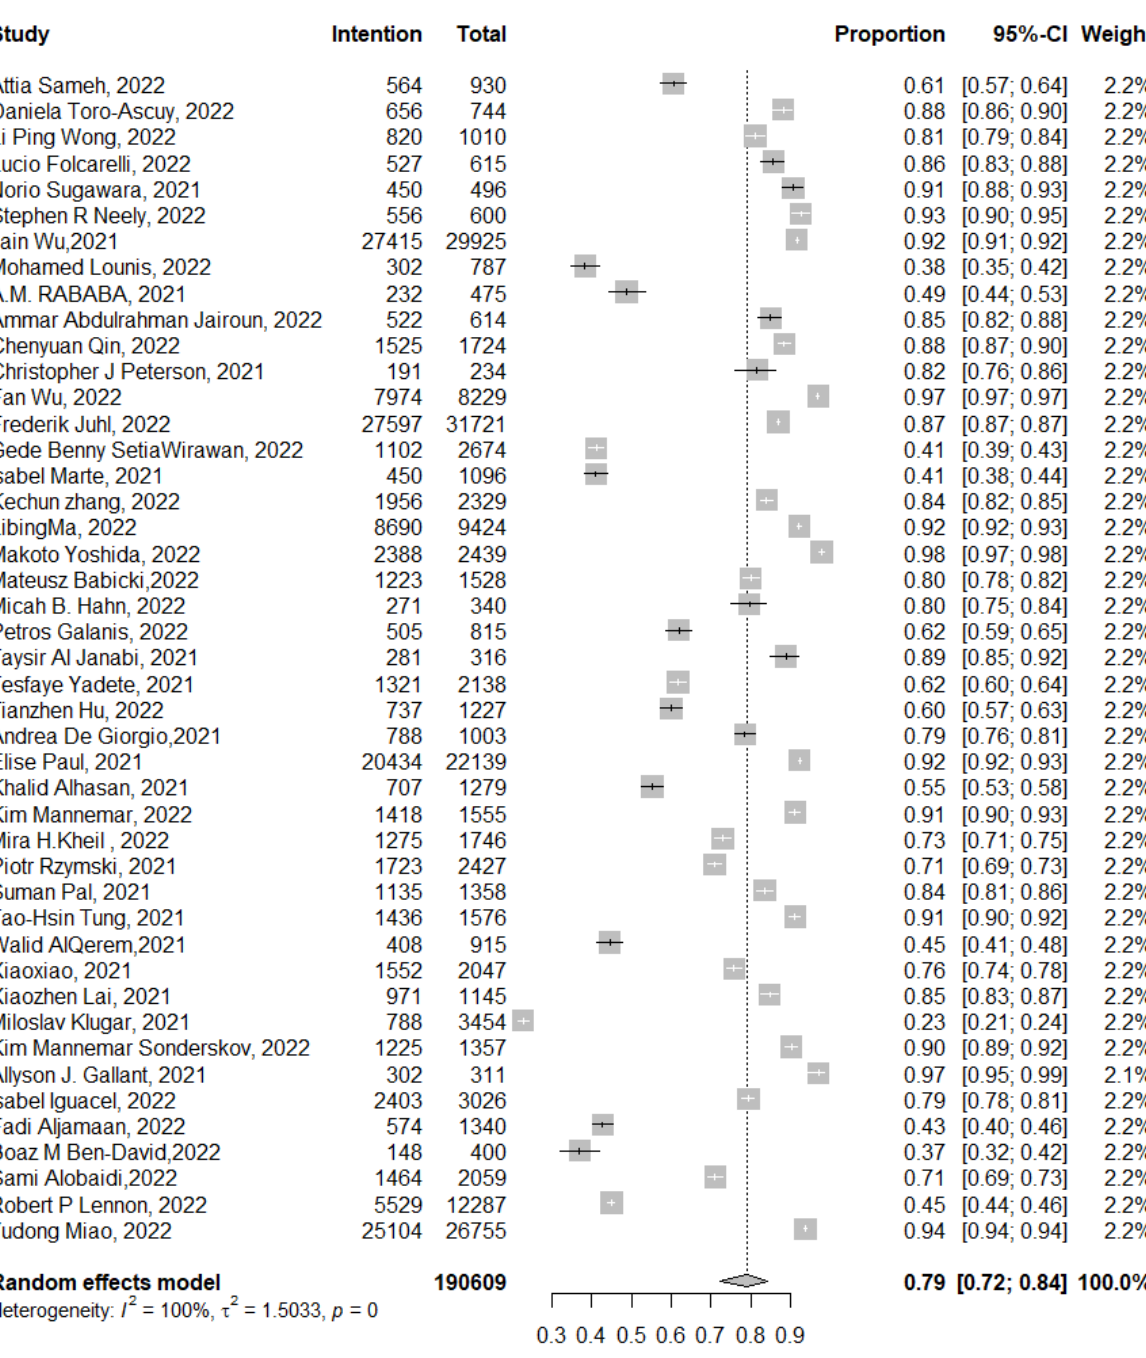
Figure 5. Forest plot of the pooled proportion of intentional COVID-19 booster dose acceptance. p = 0 denoted a p -value < 0.001.